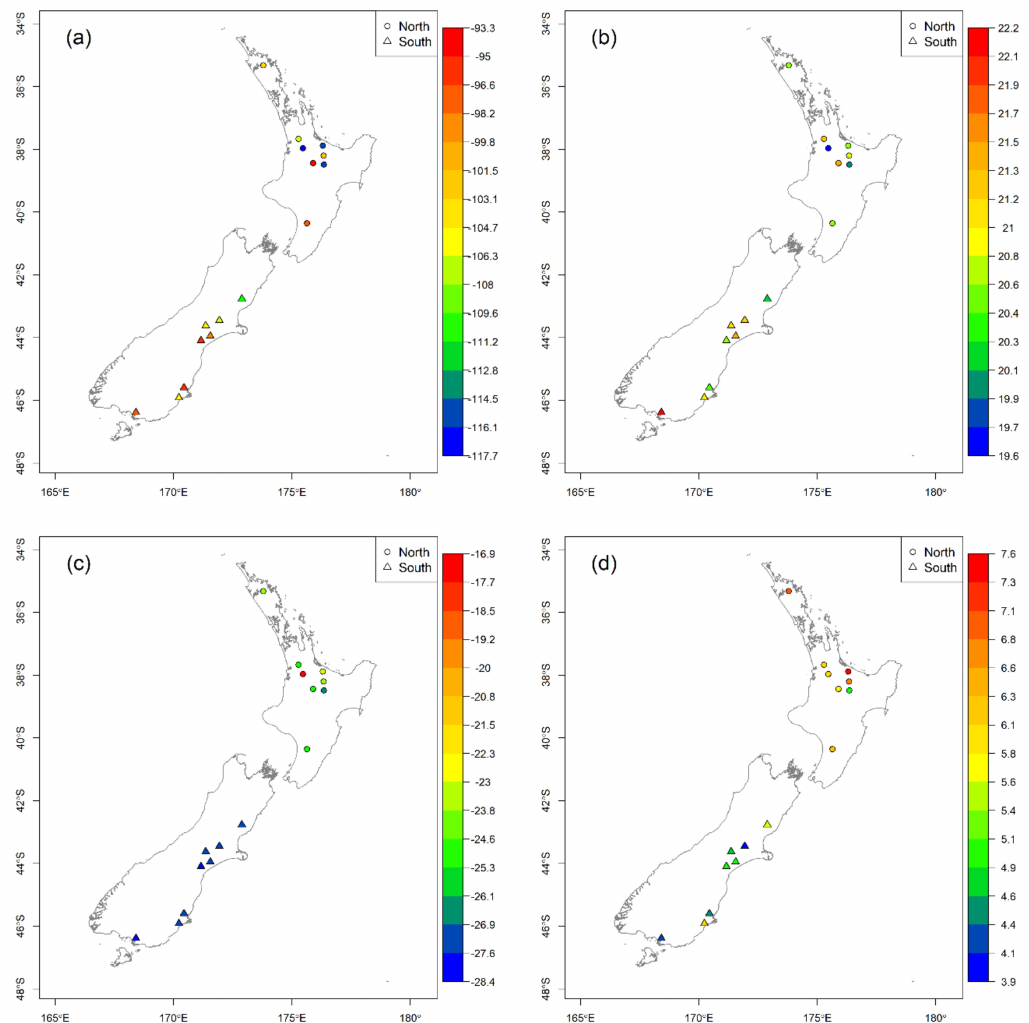
Figure 2. Distribution of stable isotopic values measured in casein samples from dairy farms across the North Island and South Island of New Zealand: ( a ) δ 2 H values of casein; ( b ) δ 18 O values of casein; ( c ) δ 13 C values of casein; ( d ) δ 15 N values of